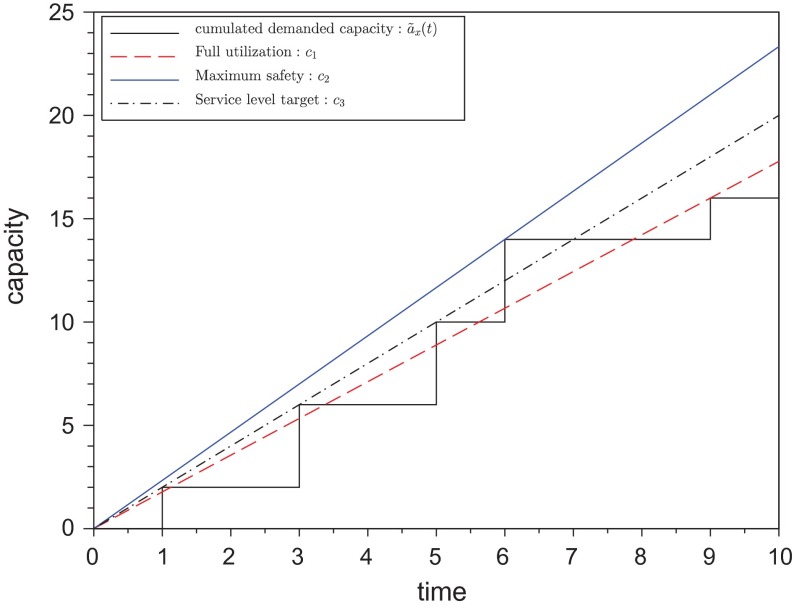
Provided capacity.